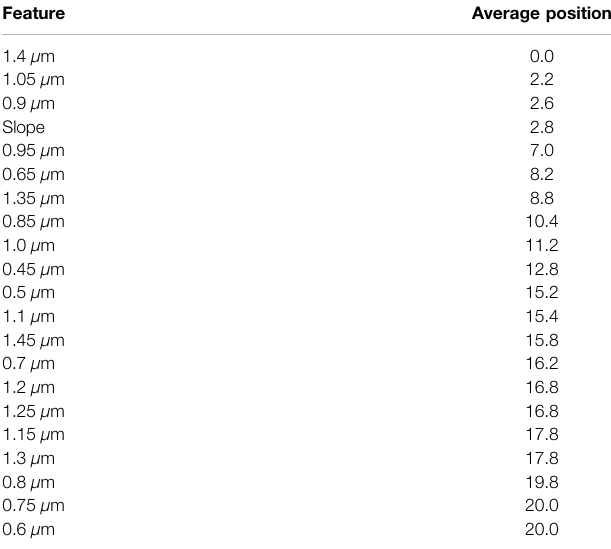
TABLE 11 | Balanced accuracy for the classi fi cation of complexes and types per step of sequential feature selection on spectral features. Feature